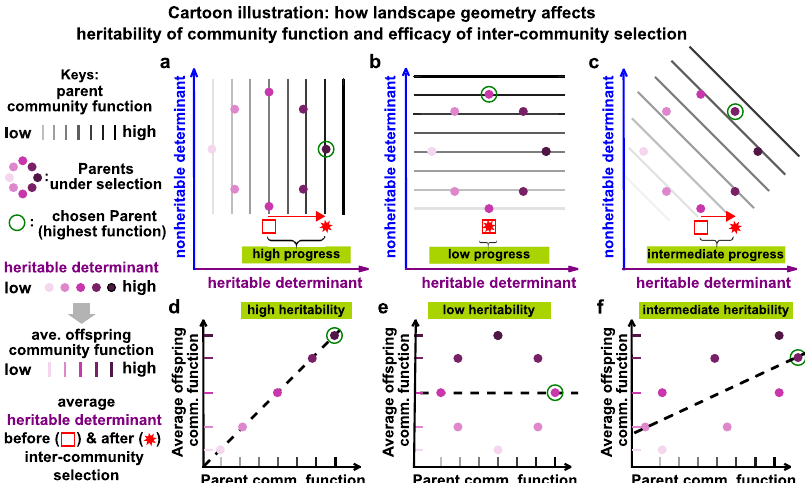
Fig. 4 The local geometry of community function landscape dictates the heritability of community function and consequently the ef fi cacy of intercommunity selection. Eight parent communities (dots) are under selection. Parent community function can be read from the gray shade of the underlying contour where a darker shade indicates a higher function (top panels). Parent ’ s heritable determinant (purple shade of the dot) dictates the average function of its offspring communities (as effects from the nonheritable determinant average out). Thus, we can plot parent function (gray shade) against average offspring function (purple shade) (bottom panels), and the slope of the least-square linear regression (black dashed line) is an estimation of community function heritability. The community with the highest function (sitting on the darkest contour) is chosen for reproduction (green open circle). Average heritable determinants before and after intercommunity selection are marked by a red square and a red star, respectively. Thus, progress made by intercommunity selection can be measured as the distance from red square to red star. Intercommunity selection is the most or the least effective when community function contours are perpendicular ( a , d ) or parallel ( b , e ) to the axis of heritable determinant, respectively, and intermediate otherwise ( c , f